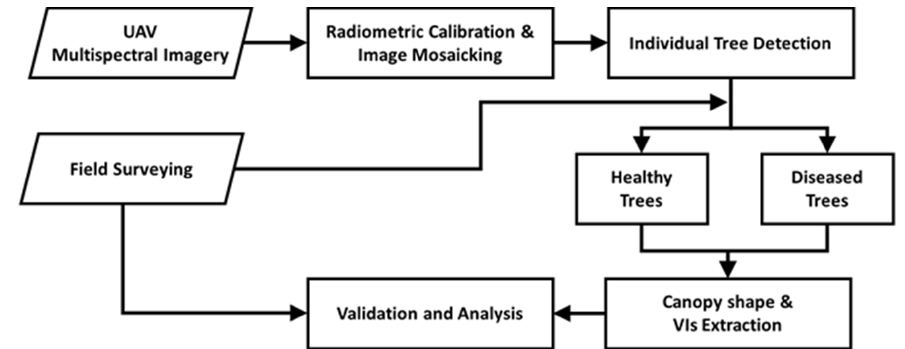
Figure 1. Citrus tree characterization procedure from unmanned aerial vehicle (UAV)-based Figure 1. multispectral imagery.